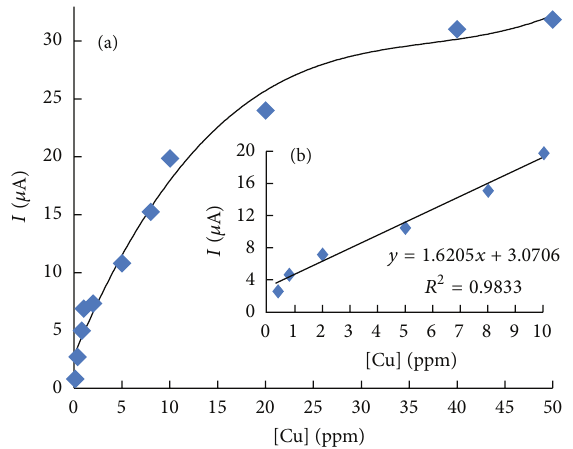
Figure 3: Effect of various preconcentration Cu(II) standards for the Acetabularia -CPE showing the (a) full range from 0.1ppm to 50 ppm and (b) linear range from 0.4ppm to 10ppm. The CPE was accumulated for 1 minute followed by a deposition potential of − 300mV and a scan rate of 100mV/s in 0.1MKNO 3 electrolyte.